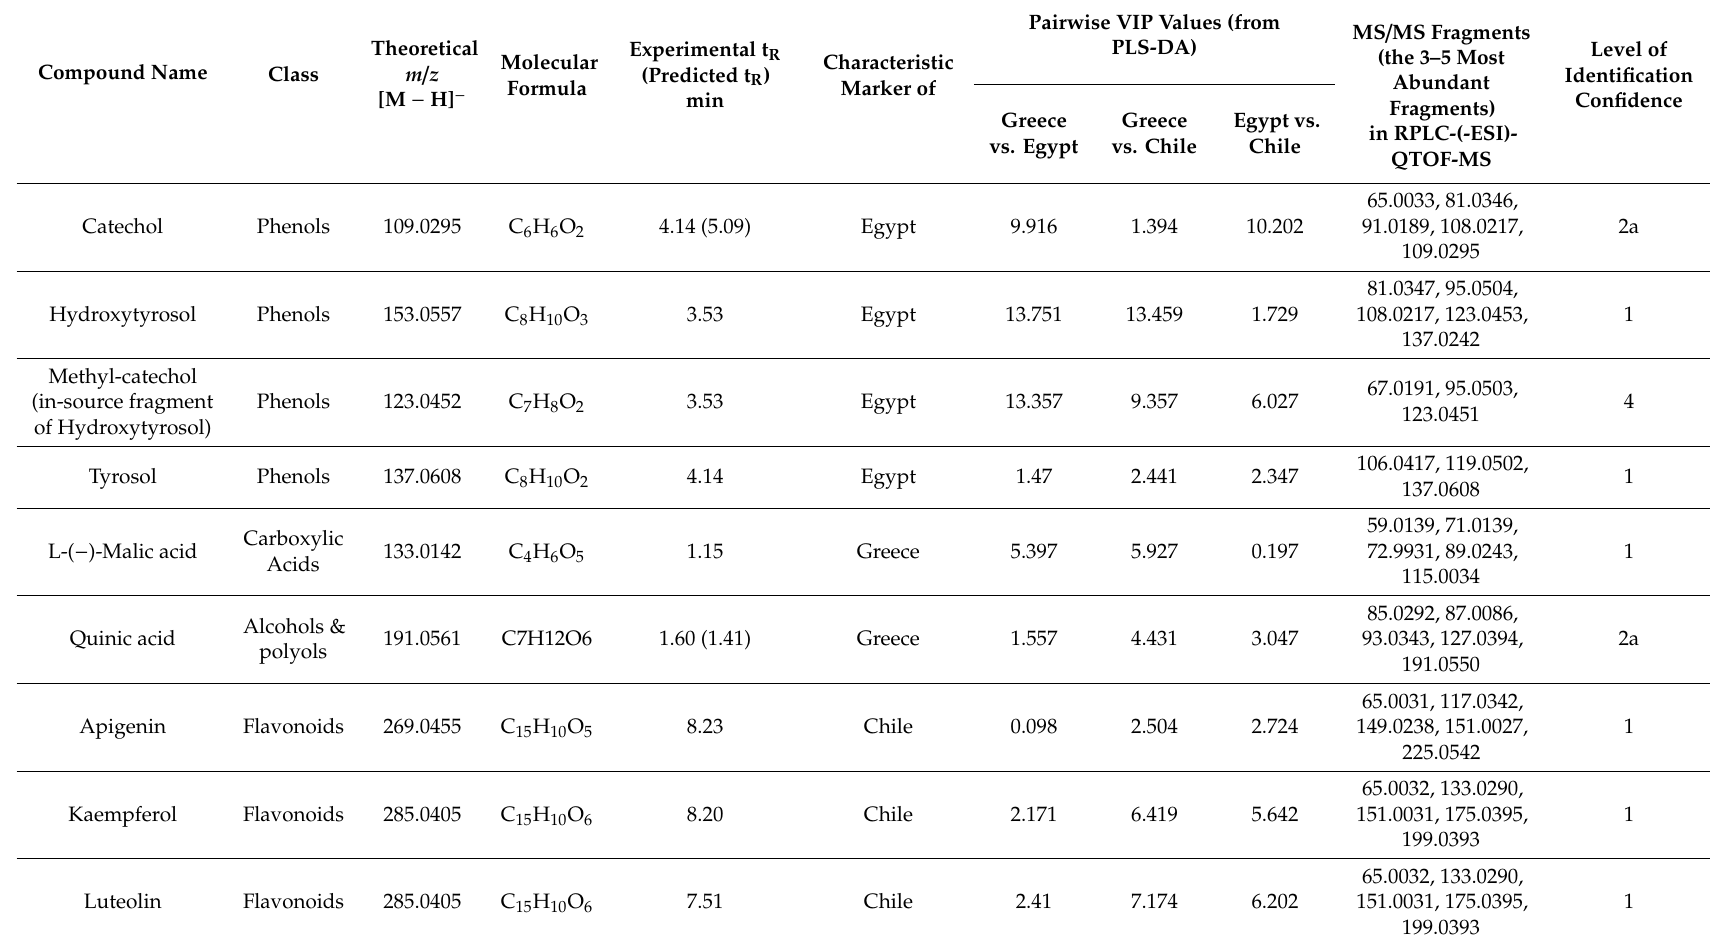
Table 2. List of the markers detected in olive drupes from di ff erent geographical